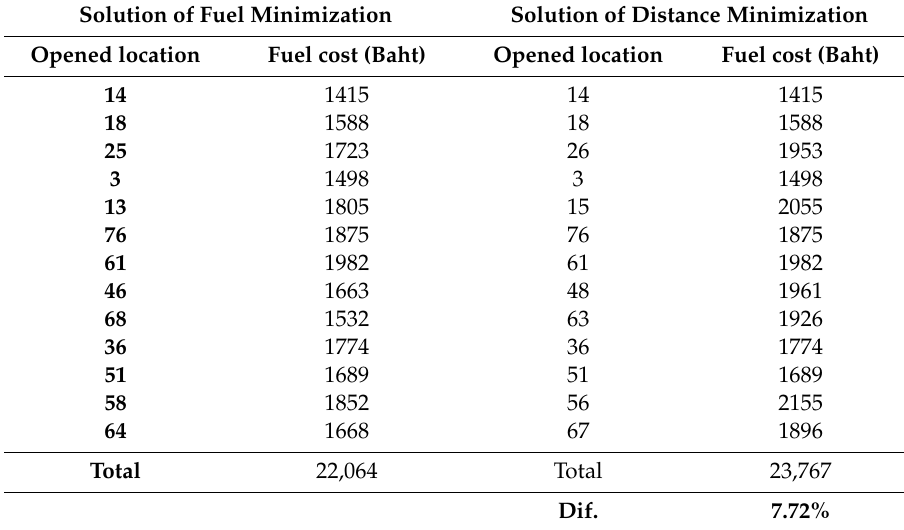
Table 11. Comparison of solution of fuel minimization and distance minimization in perspective of fuel cost.